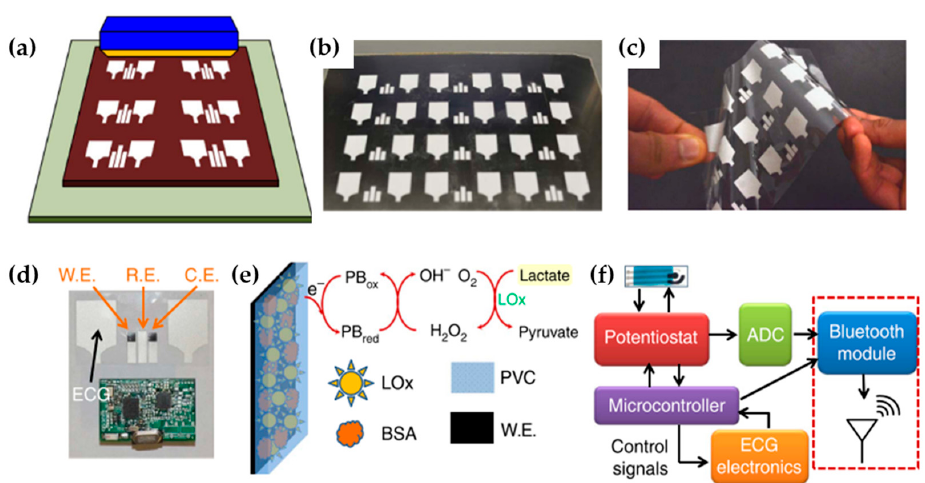
Figure 20. Fabrication and function of the Chem–Phys hybrid sensor patch. ( a ) Schematic showing the screen-printing process; ( b ) image of the Chem–Phys printing stencil; ( c ) An array of printed Chem–Phys flexible patches; ( d ) image of a Chem–Phys patch along with the wireless electronics; ( e ) Schematic showing the LOx-based lactate biosensor along with the enzymatic and detection reactions; ( f ) block diagram of the wireless readout circuit. Reprinted with permission from reference [144]. Copyright © Springer Nature Limited.